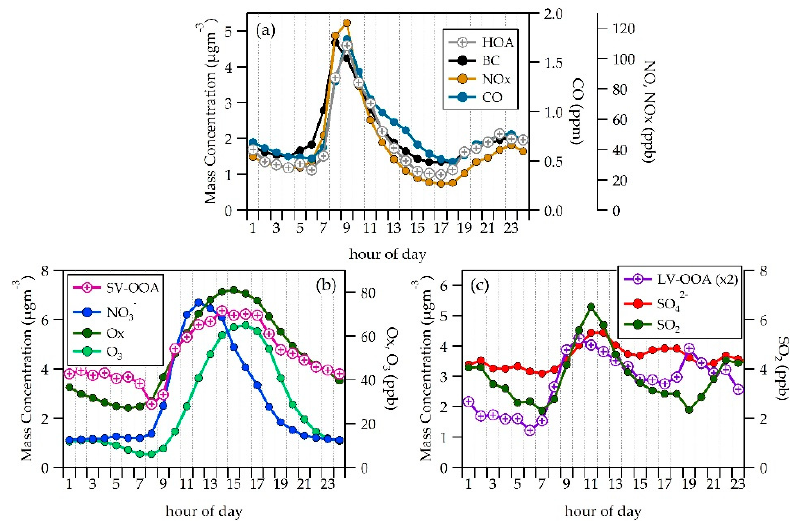
Figure 8. Average diurnal profiles of the mass concentration of the PMF-AMS organic factors during ACU15. Each factor is compared with other atmospheric species as markers of primary emissions ( a ), photochemistry ( b ), and regional transport ( c ).